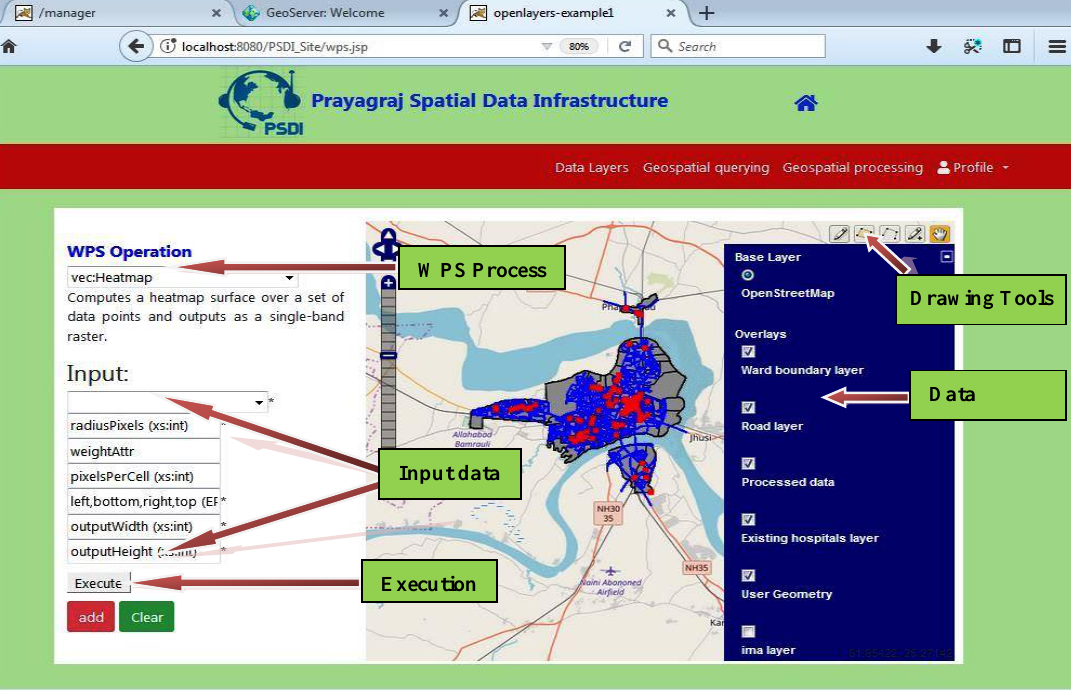
Figure 3. Developed WPS enabled prototype of public health SDI for Prayagraj